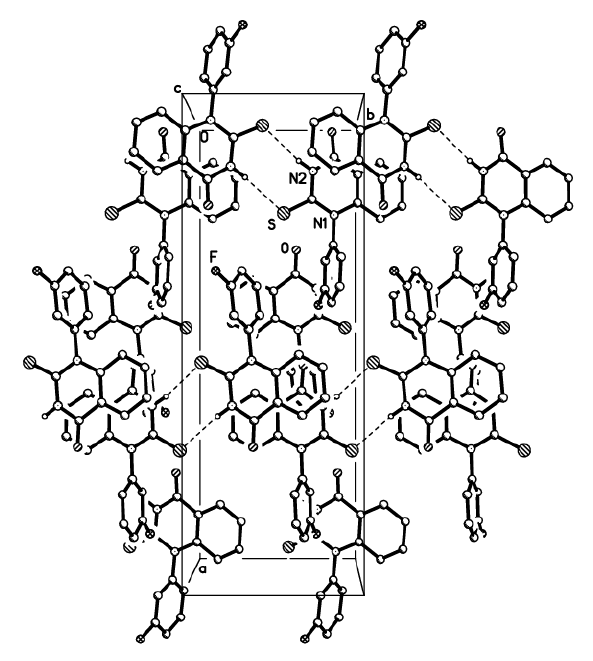
Figure 3. Crystal packing with intermolecular N-H…S interactions. H atoms not involved are